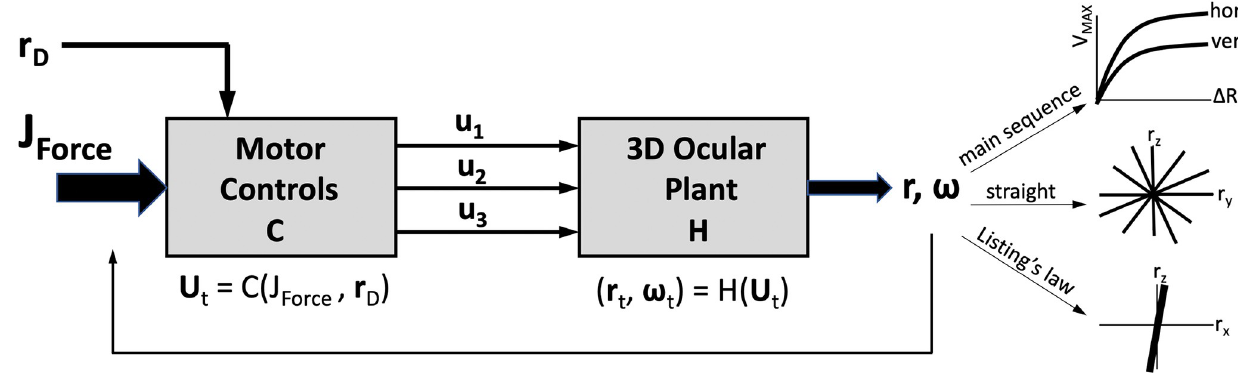
Fig 17. The total model encompasses two linked (nonlinear) components: the sequence of motor commands, U t , and the 3D eye plant, H. The plant’s output (described by 3D eye orientation, r , and angular velocity, ω ) is used to tune the cost function, J ( r , ω ), that drives the motor outputs. The t t Force system’s behavior follows the dynamics and kinematics of real saccades (insets, right). Any change in the plant’s parameters will require corresponding changes in the motor outputs, u . r : 2D target location. The thin feedback arrow represents the training phase during which eye movements recurrently t D train the motor outputs to minimize the imposed cost.